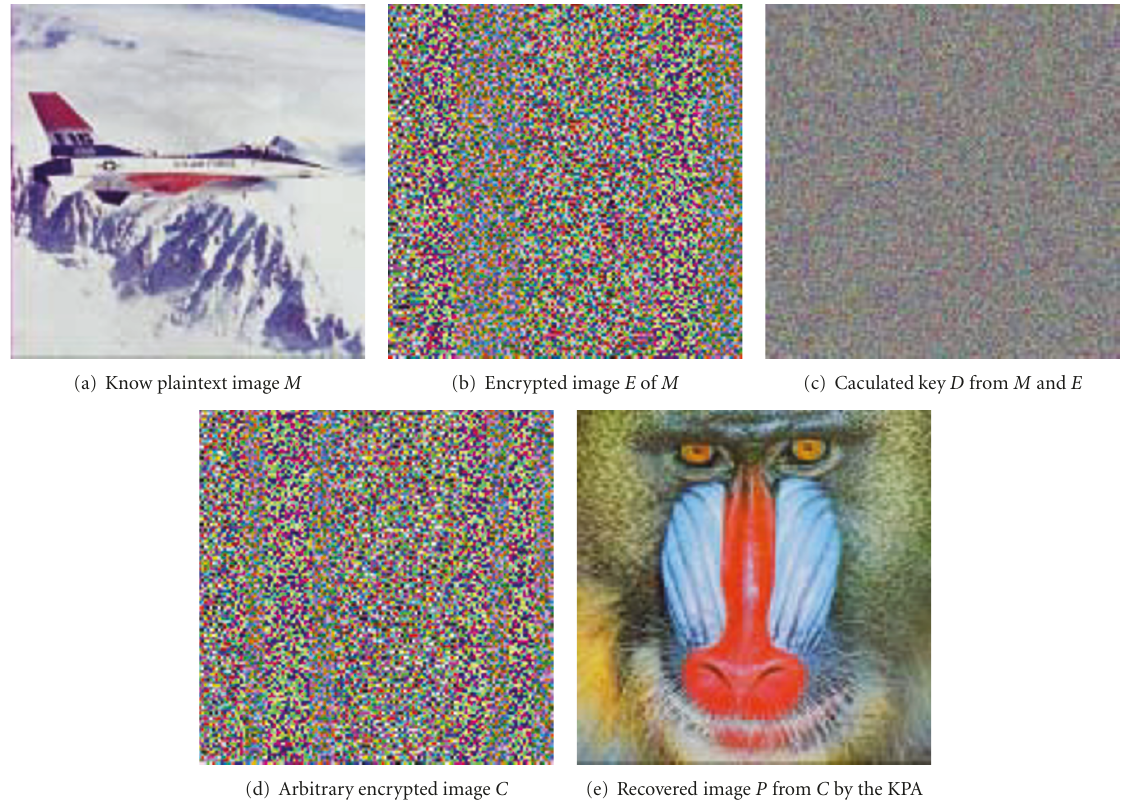
Figure 7: Simulations results of known-plaintext attack (KPA): (a) know plaintext image M ; (b) encrypted image E of M ; (c) calculated key D from M and E ; (d) arbitrary encrypted image C and (e) recovered image P from C by the